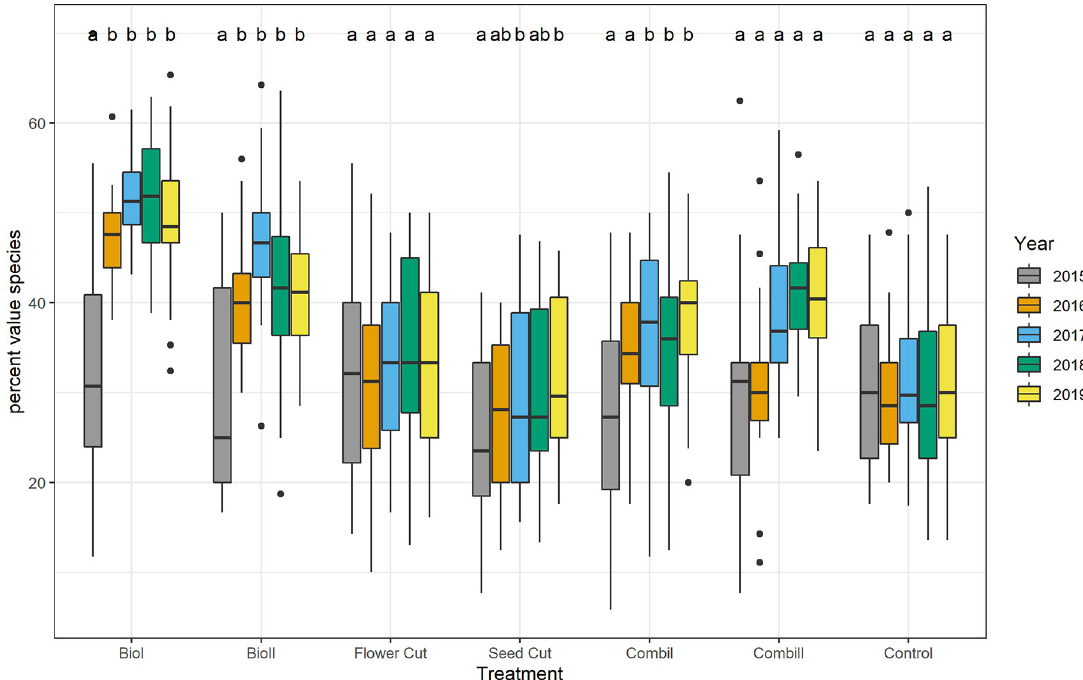
Fig 8. Percentage of value species per year and treatment. For explanation of the boxplot, refer to Fig 3. Different letters indicate significant differences (P � 0.05; Tukey HSD) between years within one treatment.